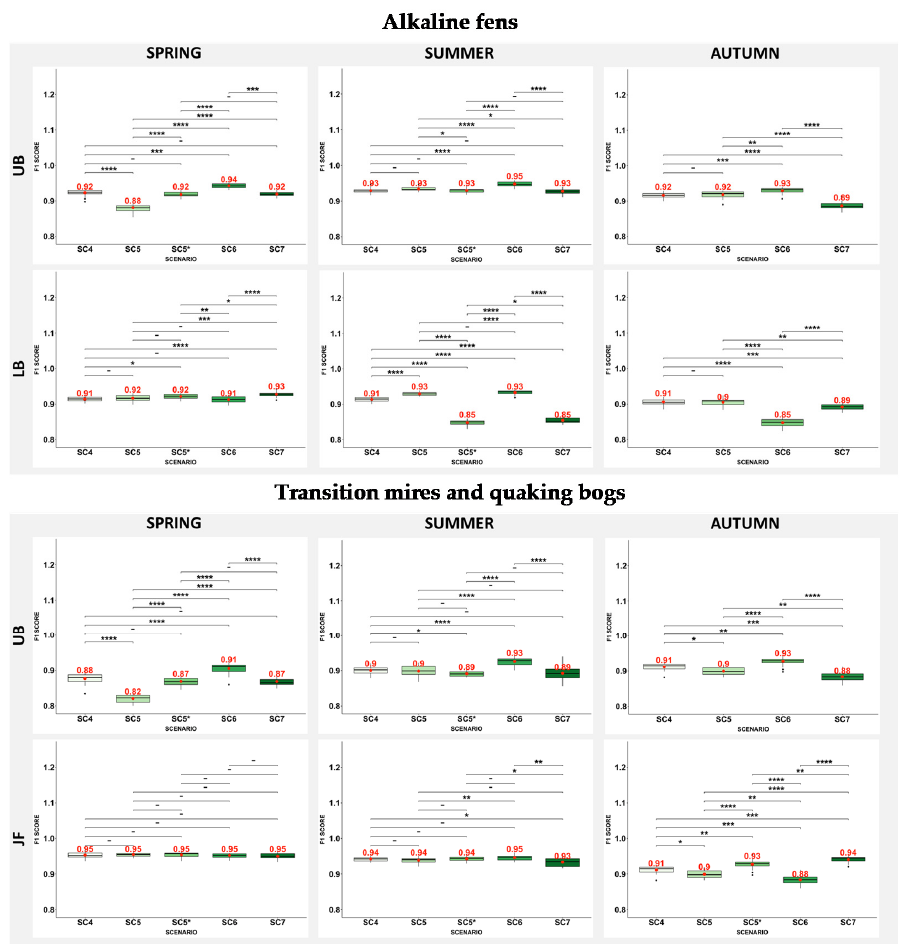
Figure 8. Boxplots of the F 1-SCORE values of alkaline fens and transition mires and quaking bogs in the UB, LB, and JF areas divided into the campaigns corresponding to the period of the growing season. Each box includes the median (central line), mean (red font), the 25th and 75th percentile (the edges of the box), extreme data points (whiskers), outliers (dots), and statistical significance (stars).